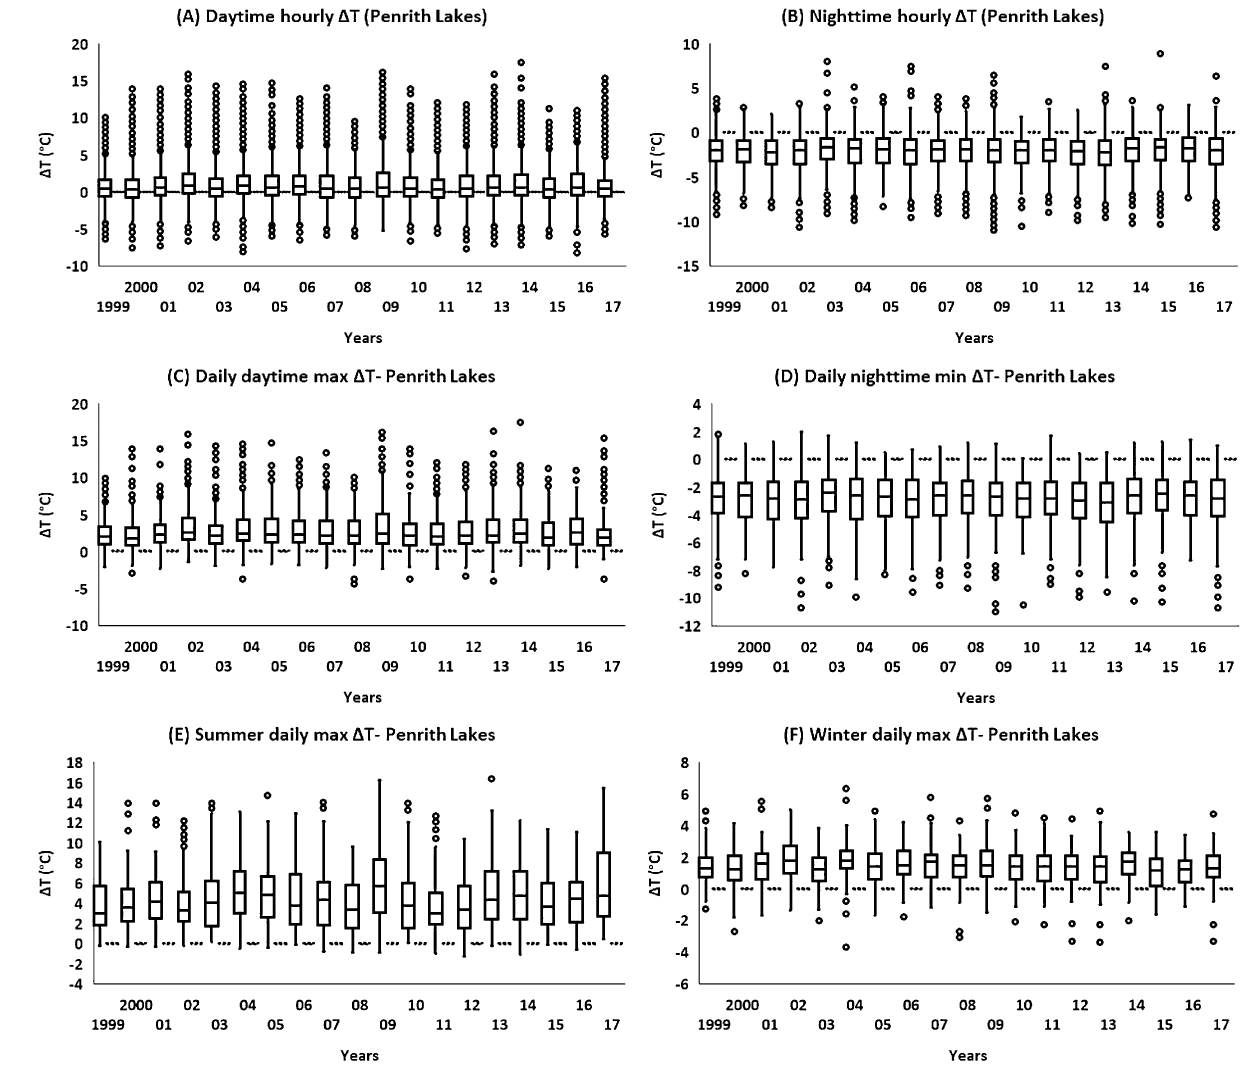
Figure 3. Variations in ΔT at Penrith Lakes over the time (1999–2017). ( A) daytime hourly variations in ΔT, ( B) nighttime hourly variations in ΔT, ( C) Variations in daily max ΔT, ( D) Variations in daily min ΔT, ( E) Variations in daily max ΔT during summer, ( E) Variations in daily max ΔT during winter. ΔT = 0 is illustrated by a dotted line. The boxplots are plotted according to the general convention (Q1-1.5*IQR and Q3 + 1.5*IQR), while the remaining dataset represents the outliers. ΔT (Penrith Lakes—OBS Hill)